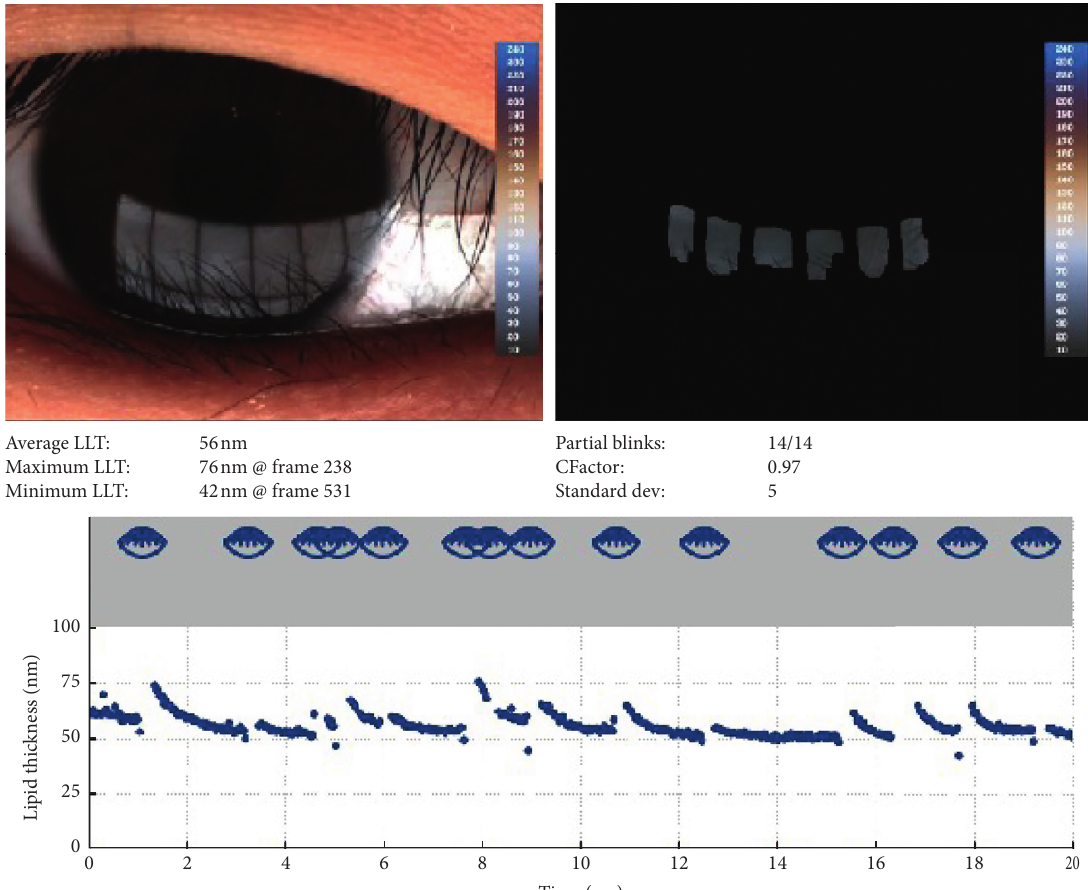
Figure 1: Display of LLTand blinking pattern on-screen of LipiView ® interferometer. The result of LLT (average, minimum, and max) of a participant on the screen of LipiView. CFactor: reliability index, which needs to be above 0.7. Partial blinks: before slash is number of partial blinks, and after slash is number of all blinks during